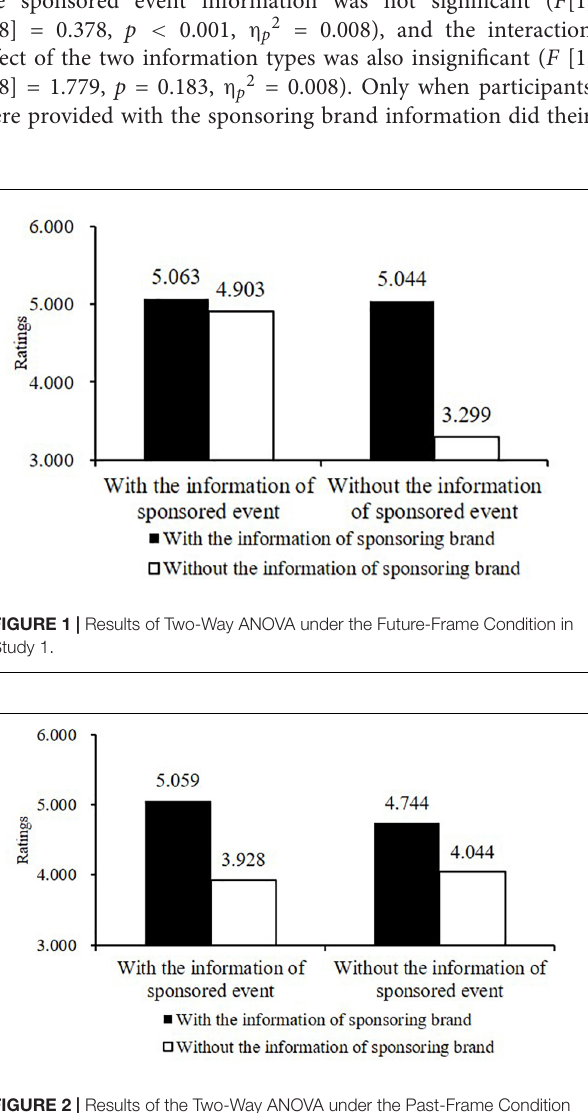
FIGURE 2 | Results of the Two-Way ANOVA under the Past-Frame Condition in Study